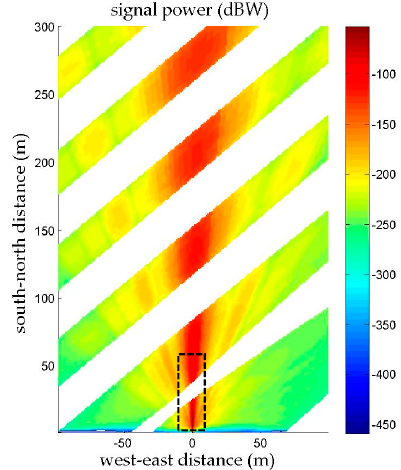
Figure 7. IF component power distribution. The strongest power − 53 dBW occurs at the dominant facet which is located at (0, 7) in the main lobe. Some directional spreading around the main lobe also presents because of the side lobes as shown in Figure 5, but all of them are over 100 dBW under the power from dominant facet so that they have hardly any impact on the measurement.